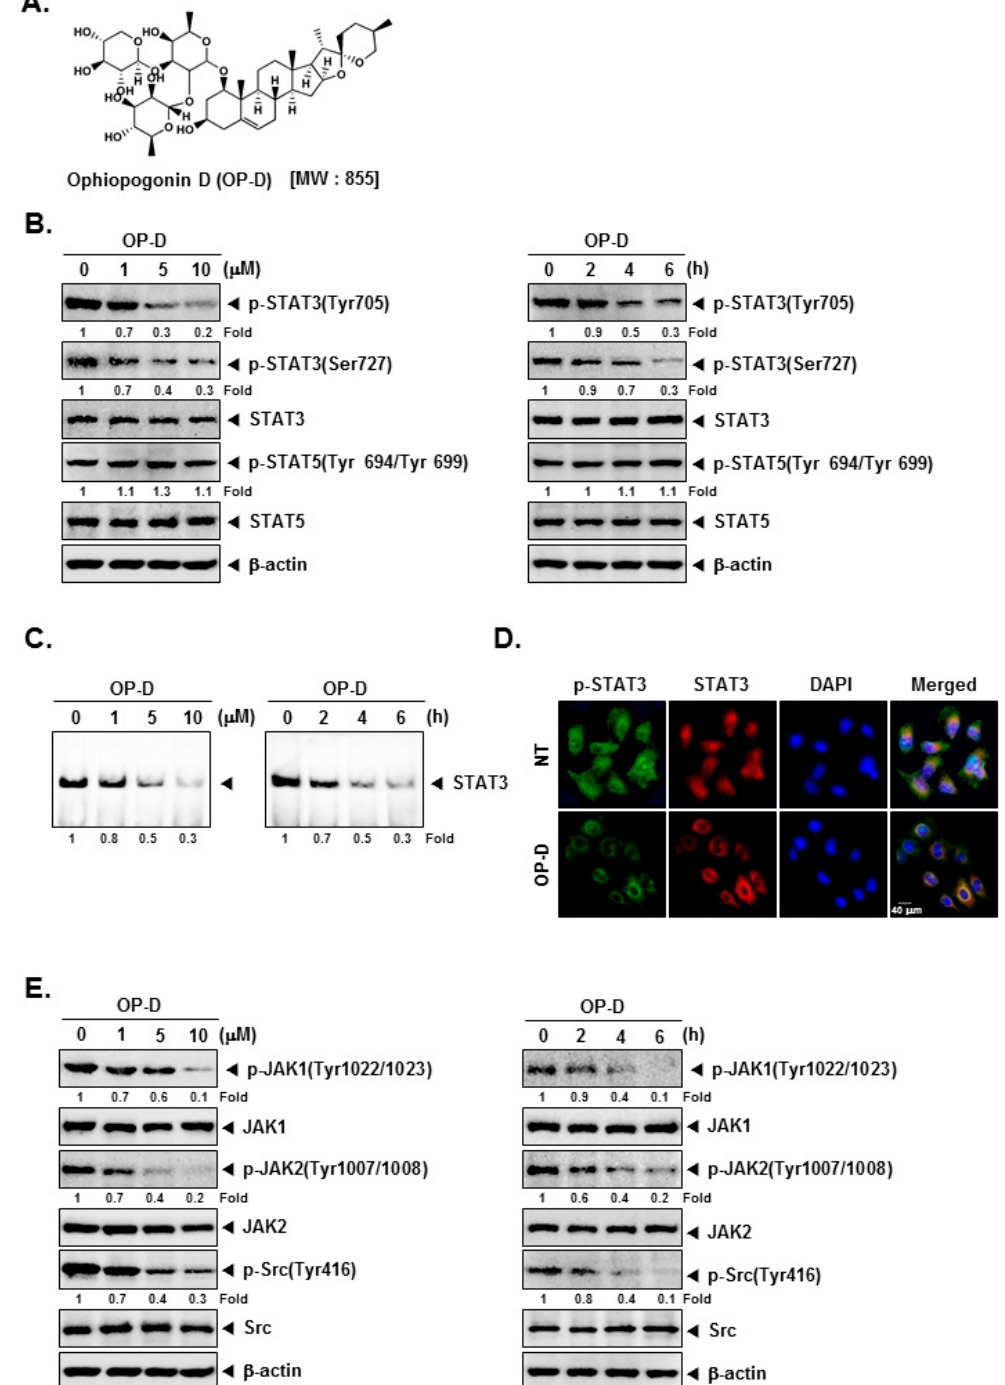
Figure 1. Ophiopogonin D (OP-D) blocks the Stat3/Jak signaling pathway. ( A ) The chemical structure of OP-D. ( B ) A549 cells were treated with the indicated concentrations of OP-D for 6 h (left panel) and treated with 10 µ M of OP-D for various time intervals (right panel). Thereafter, equal amounts of lysates were analyzed by Western blot analysis using various antibodies. ( C ) A549 cells were treated as described above and electrophoretic mobility shift assay was done. ( D ) A549 cells were treated with 10 µ M of OP-D for 6 h and then analyzed for the intracellular distribution of by immunocytochemistry. ( E ) A549 cells were treated as described above in panel A and Western blot was performed using various